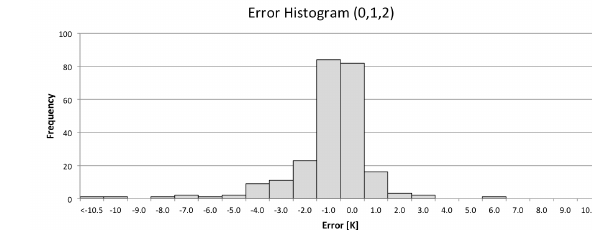
Figure 10: Histogram of error values for small subset of cloud free Landsat 8 scenes processed using band 11.